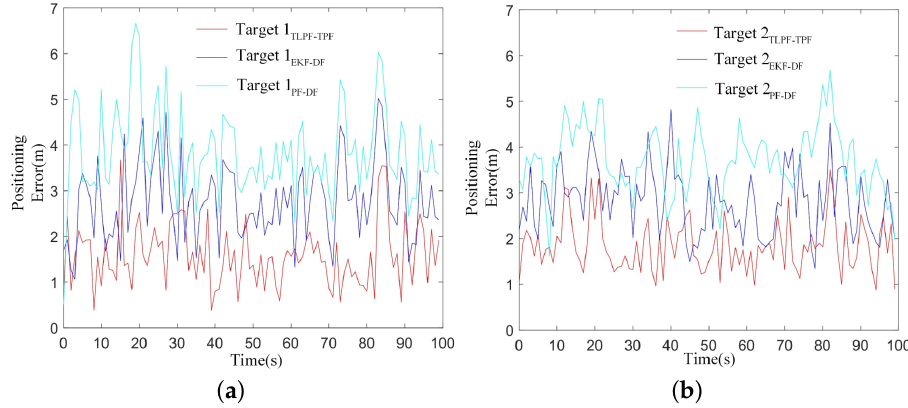
Figure 8. Targets’ Tracking Error Under Gaussian Mixture Noise. ( a ) Target 1’s Positioning Error under Gaussian Mixture Noise. ( b ) Target 2’s Positioning Error under Gaussian Mixture